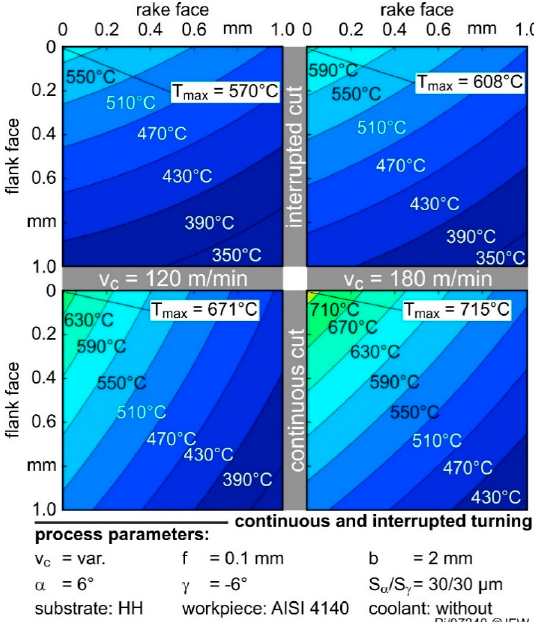
Figure 6. Tool temperatures of different contact conditions and cutting speeds. (The calculated maximum temperatures take the geometry of the cutting edge into account).